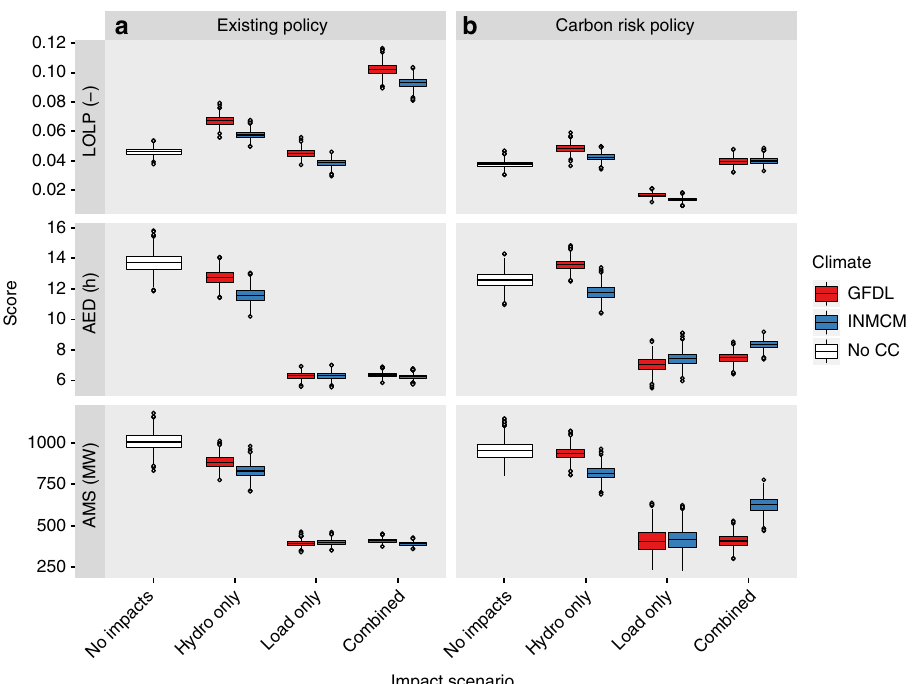
Fig. 2 Power system adequacy with 2035 infrastructure. Results are given for existing and carbon risk policy scenarios. Metrics are loss of load probability (LOLP), average event duration (AED), and average maximum shortfall (AMS). Uncertainty distributions are derived for each case using a bootstrap with 1000 repetitions. Boxplots follow the Tukey convention, with fi ve summary statistics (median, 25th and 75th percentiles, 1.5* interquartile range) and all outlier